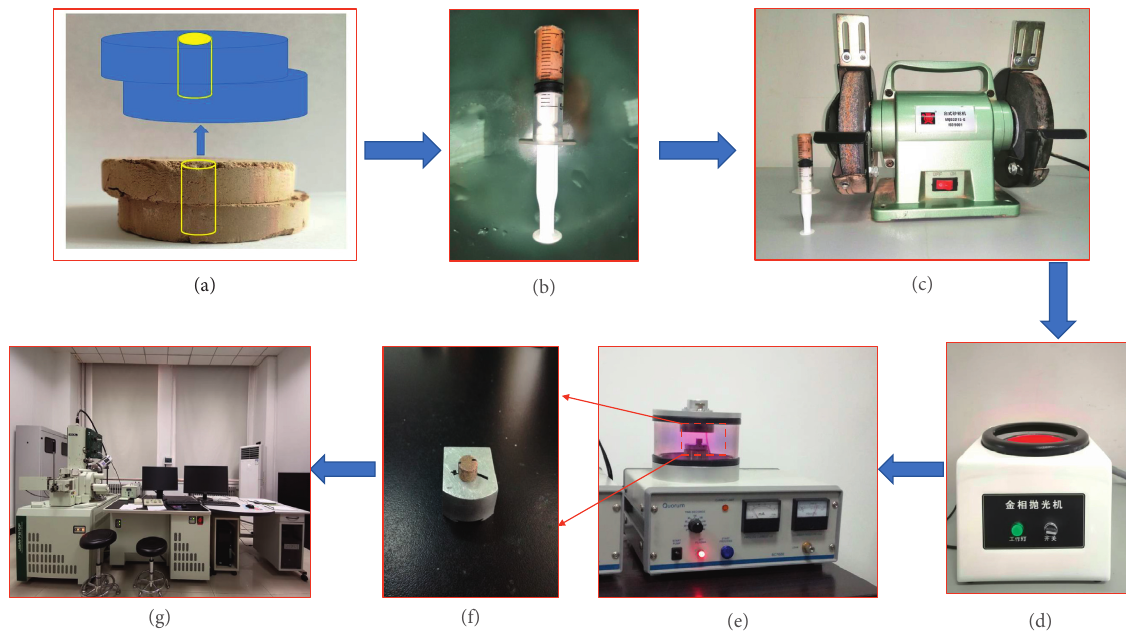
Figure 8: Scanning electron microscope sample preparation process. (a) Sample after direct shear creep test; (b) cylinder sample; (c) grinding machine used to grind the specimens; (d) polishing machine used for polishing; (e) sputter coater used for spraying samples with gold; (f) sample after being sprayed with gold; (g) scanning electron microscopy.